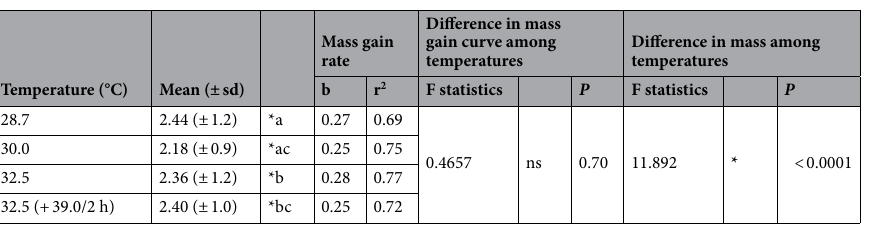
Table 1. Mass gain rate during the incubation period of Tropidurus torquatus eggs under four temperature regimes. Significant effect of incubation temperature is indicated by (*); letters *a, *b, & *c denotes the post-